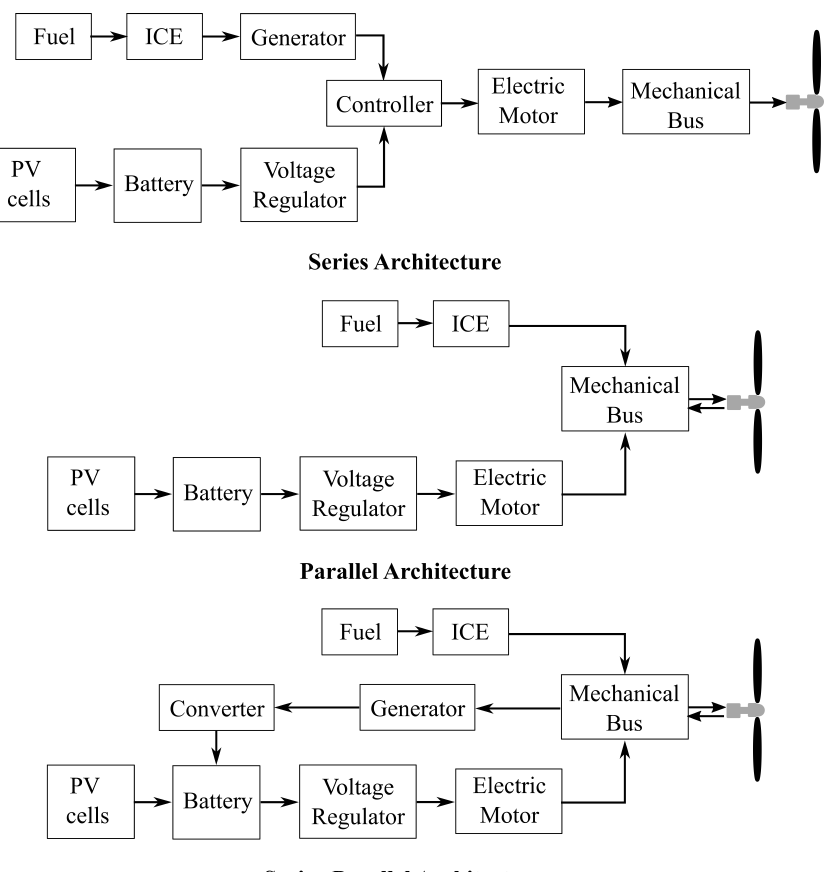
Figure 3. Hybrid propulsion